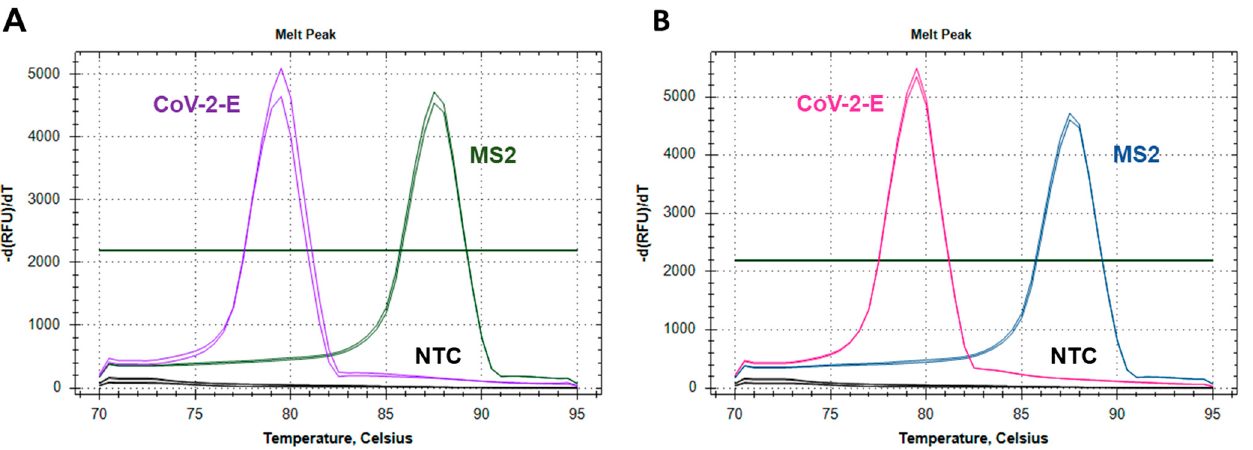
Figure 2. Melting curve analysis of the LAMP products. The graph represents characteristic melting peaks for LAMP products obtained with ( A ) monoplexes CoV-2-E (pink curves) and MS2 (blue curves); ( B ) duplex MS2-CoV-2-E, where green curves correspond to MS2 and purple curves to CoV-2-E.